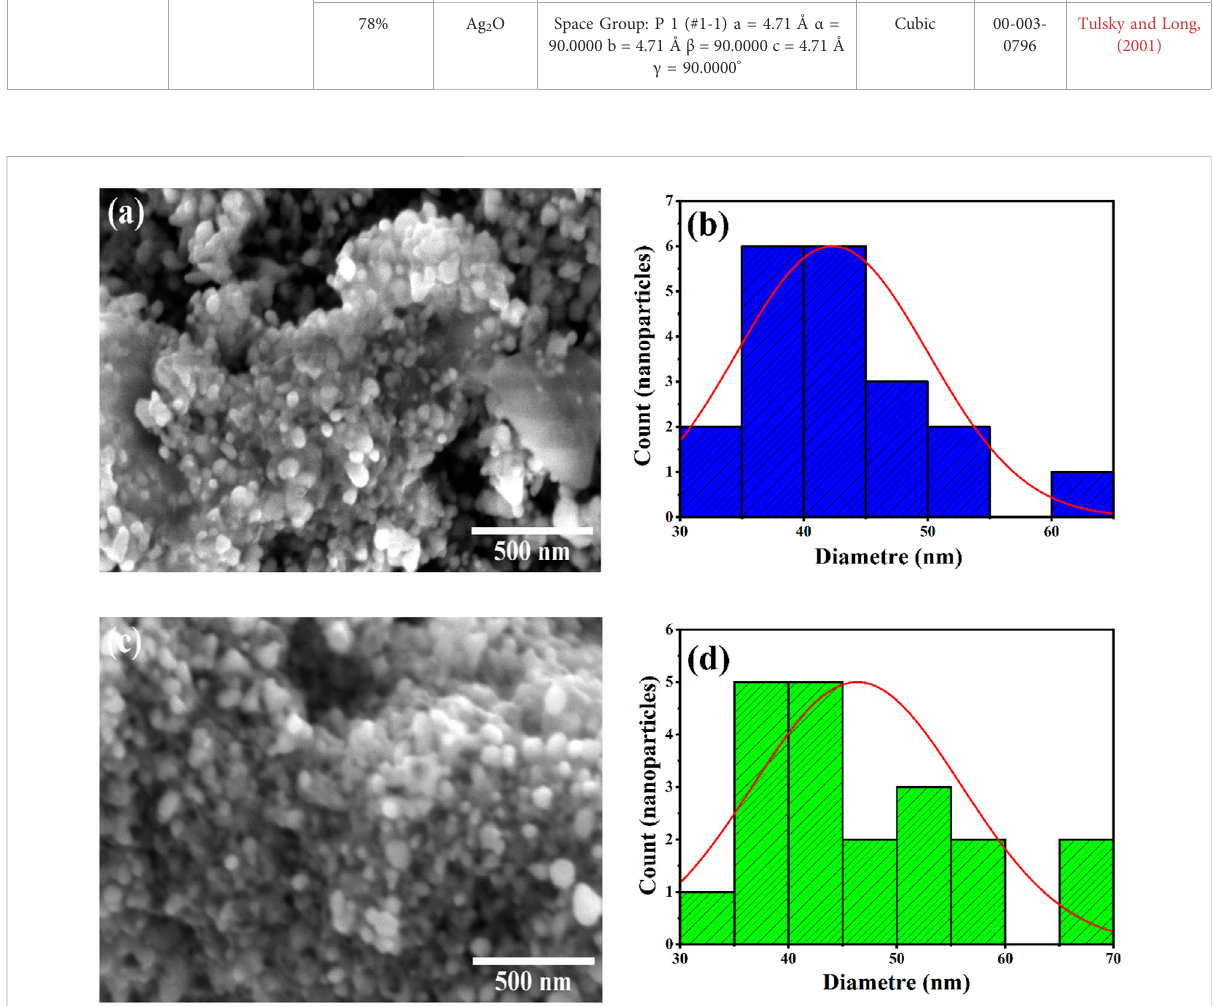
FIGURE 2 SEM images and particle size distributions: (A,B) AgO/Ag 2 O NPs, (C,D) MgO@AgO/Ag 2 O NPs.